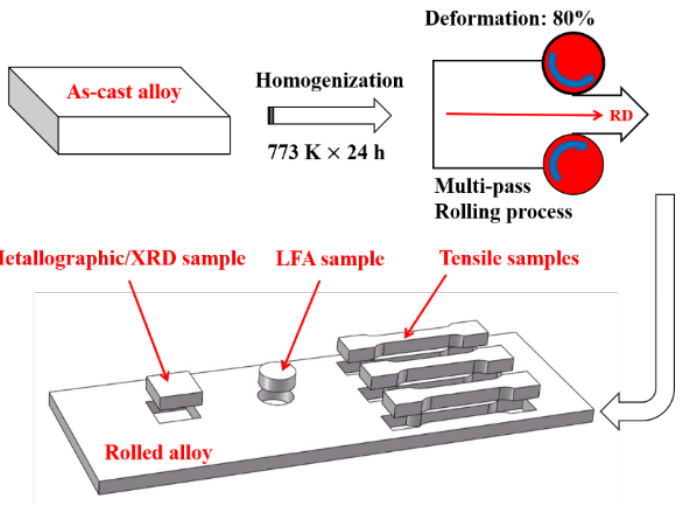
Figure 1. A schematic diagram of the rolling process and position of the metallographic sample, LFA (Laser flash) sample, and tensile samples obtained from the rolled Al-2Fe- x Co alloys. The total rolling deformation was 80%. The as-cast, annealed, and rolled plates were machined into tensile samples. All tensile tests were conducted at ambient temperature.